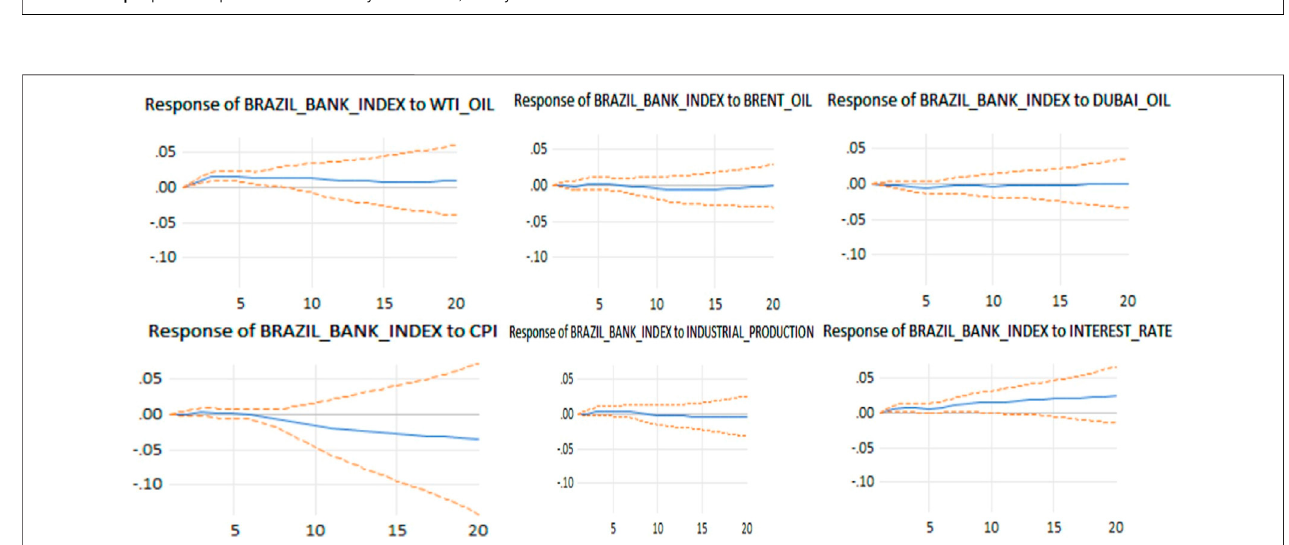
FIGURE 4 | Impulse response function analysis: Brazil.